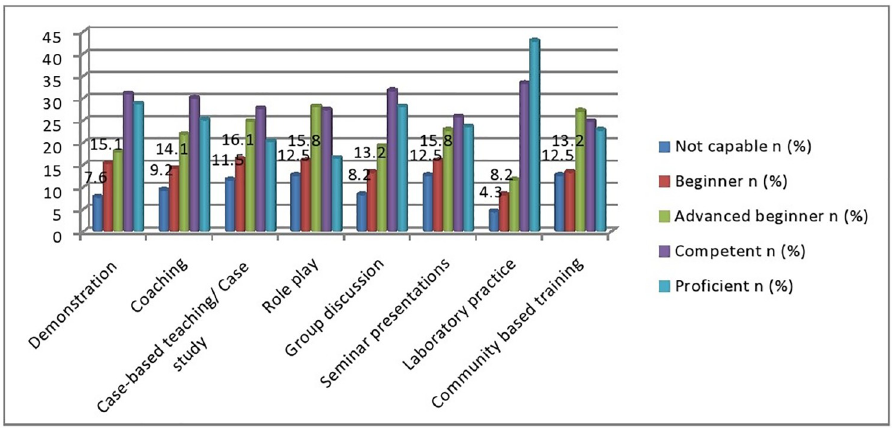
Fig 1. Apply different hands-on teaching strategies/ methods that are matched to the learning outcomes of preceptors for Medical Laboratory Science clinical practicum education programs in Ethiopia, 2021(N = 304).